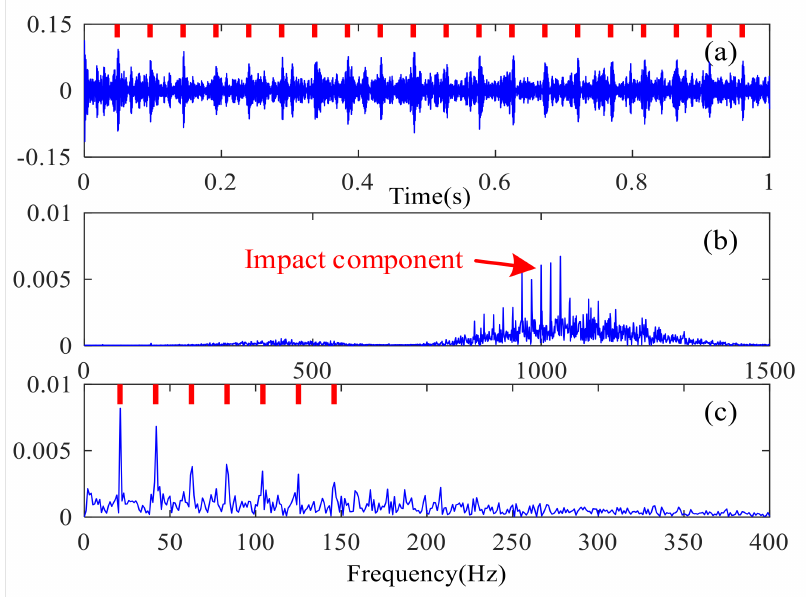
Figure 10. Denoising results: ( a ) reconstructed signal, ( b ) frequency spectrum, and ( c ) envelope spectrum. The main components of the final retention are mainly from x 4 and x 5 in the pre- decomposition stage, and the whole FEI level is above 0.185. It should be noted that the FEI of x 4 is low, which indicates that the proposed method can detect and extract weak fault impulse components. For the obtained denoising signal in Figure 10, the impulse features caused by the fault are obvious in the time domain. The impulse period is about 0.048 s, and the frequency is about 20.83 Hz, which coincides with the fault feature frequency f 0 . The average amplitude of impulse is still quite large compared with the original fault component. The envelope spectrum of the denoising signal shows that the peak value at point f 0 is obvious. In addition, the denoising signal’s frequency